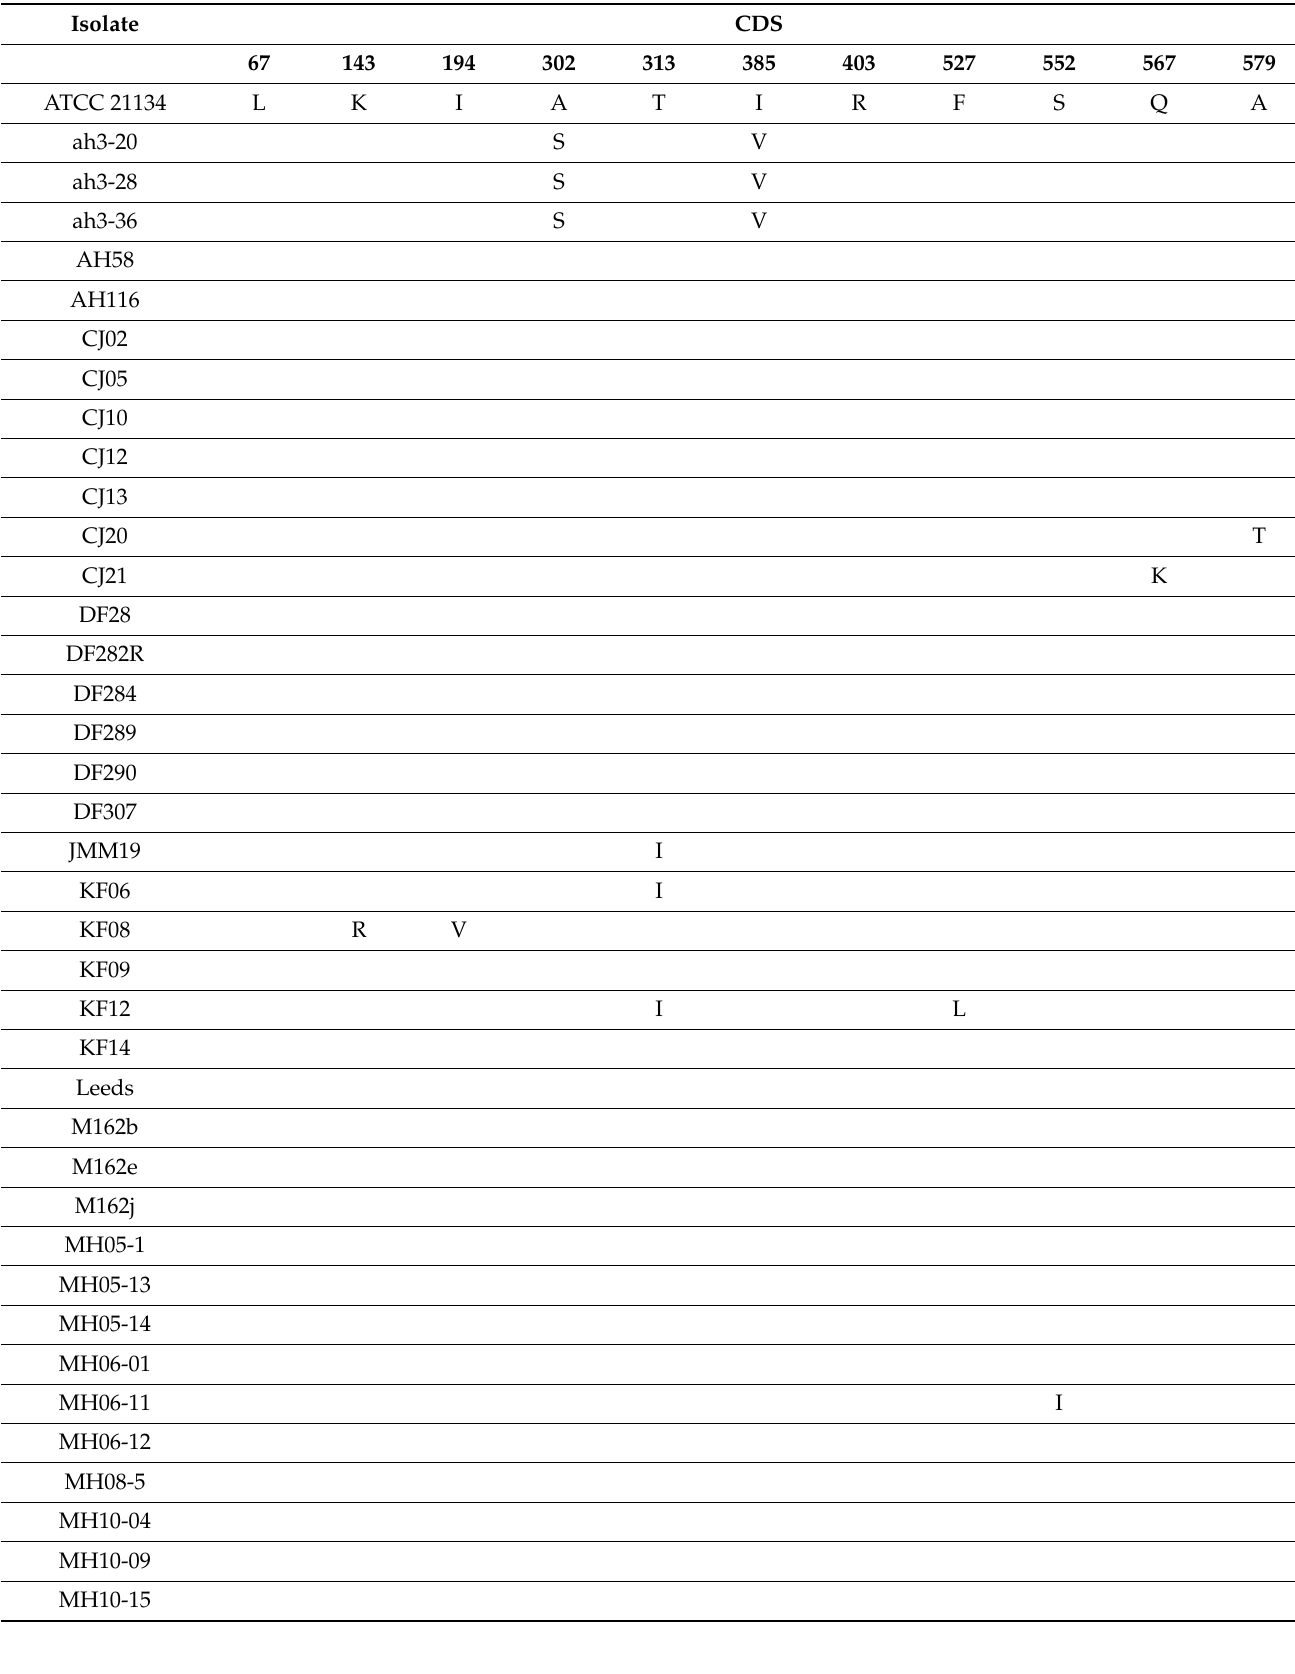
Table A2. Amino acid variations present in the gyrB genes of all isolates analyzed in reference to ATCC 21134.